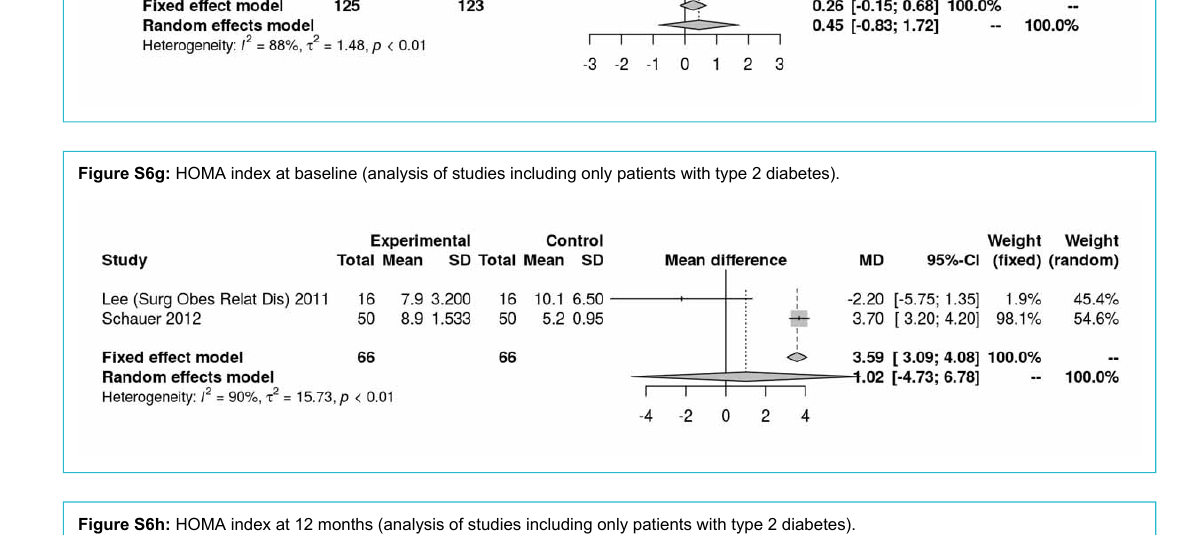
Figure S6h: HOMA index at 12 months (analysis of studies including only patients with type 2